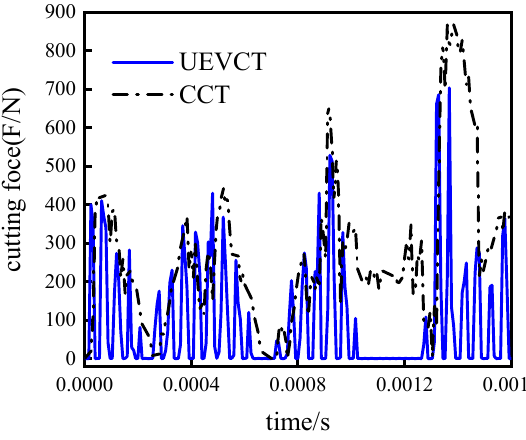
Figure 6. Comparison curve of cutting force.